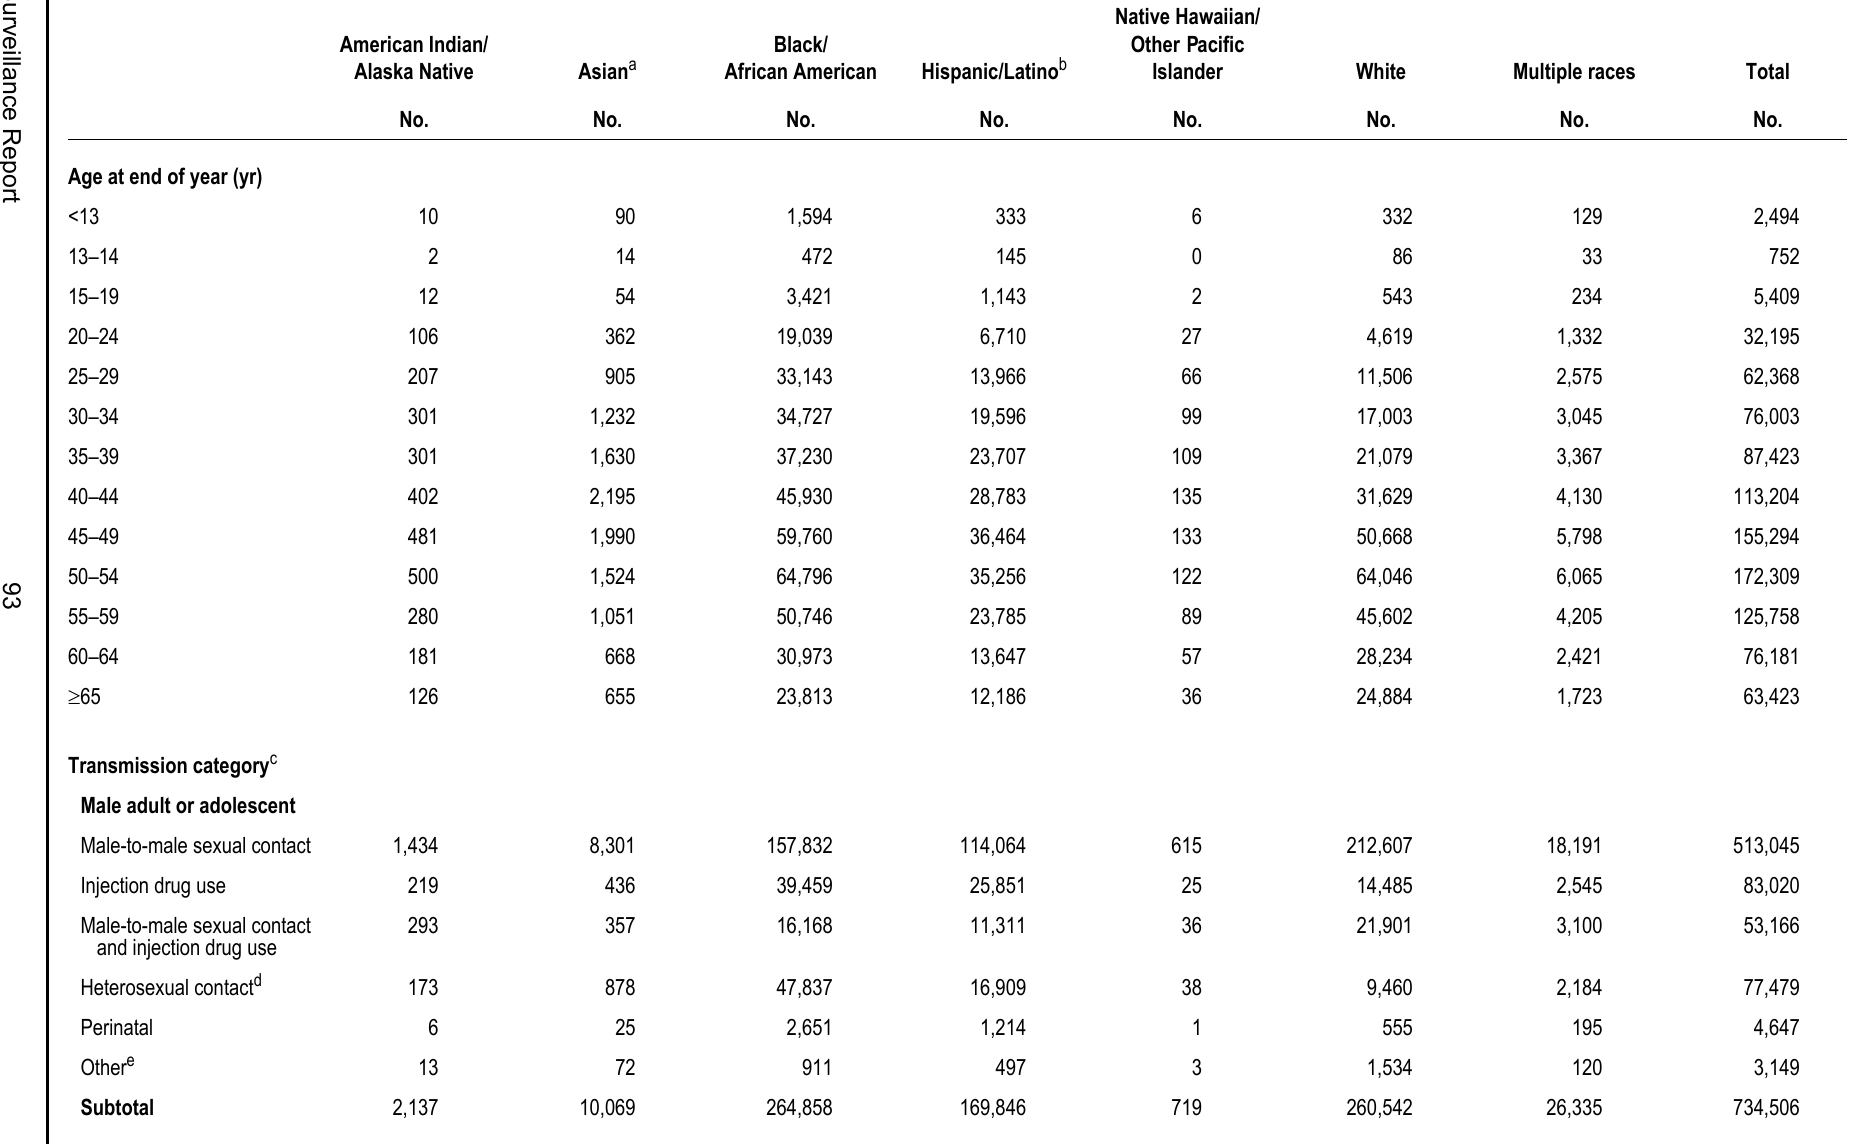
Table 20b. Persons living with diagnosed HIV infection, by race/ethnicity and selected characteristics, year-end 2014—United States and 6 dependent areas Native Hawaiian/ American Indian/ Black/ Other Pacific Alaska Native Asian a African American Hispanic/Latino b Islander White Multiple races